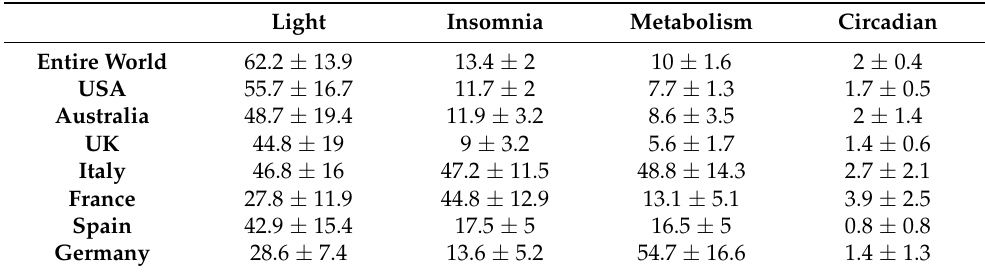
Table 2. Mean values of relative search volumes associated with light, insomnia, metabolism, and circadian in the entire world, United States of America (USA), Australia, United Kingdom (UK), Italy, France, Spain, and